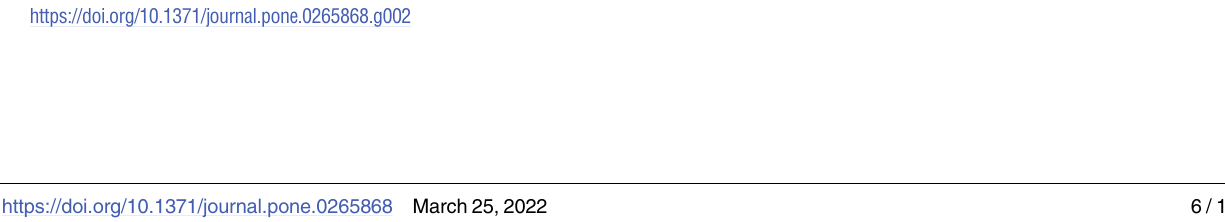
PLOS ONE | https://doi.org/10.1371/journal.pone.0265868 March 25, 2022 6 /